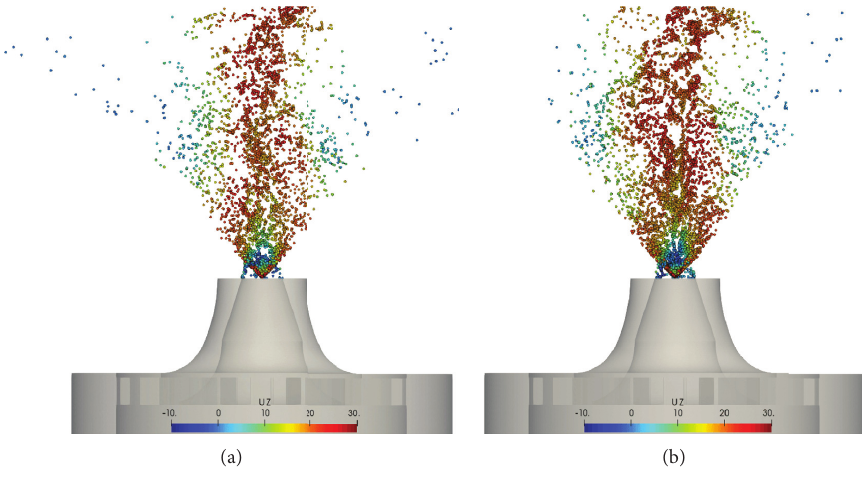
Figure 23: Droplet axial velocity for cases A-R (a) and B-R (b).